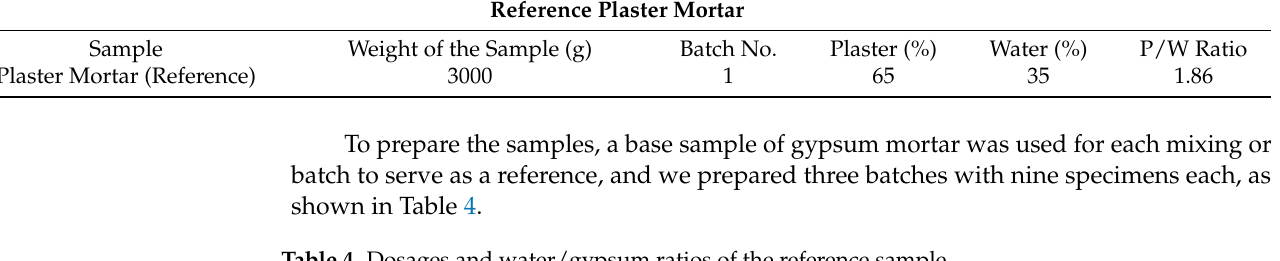
Table 4. Dosages and water/gypsum ratios of the reference sample.